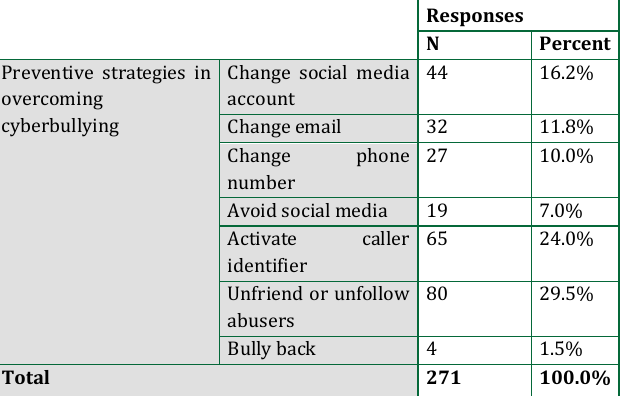
Table 11: Preventive strategies in overcoming